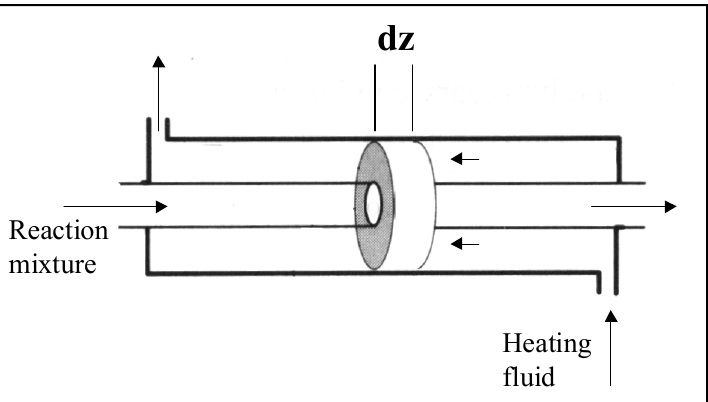
Figure 14. Double-pipe countercurrent reactor.